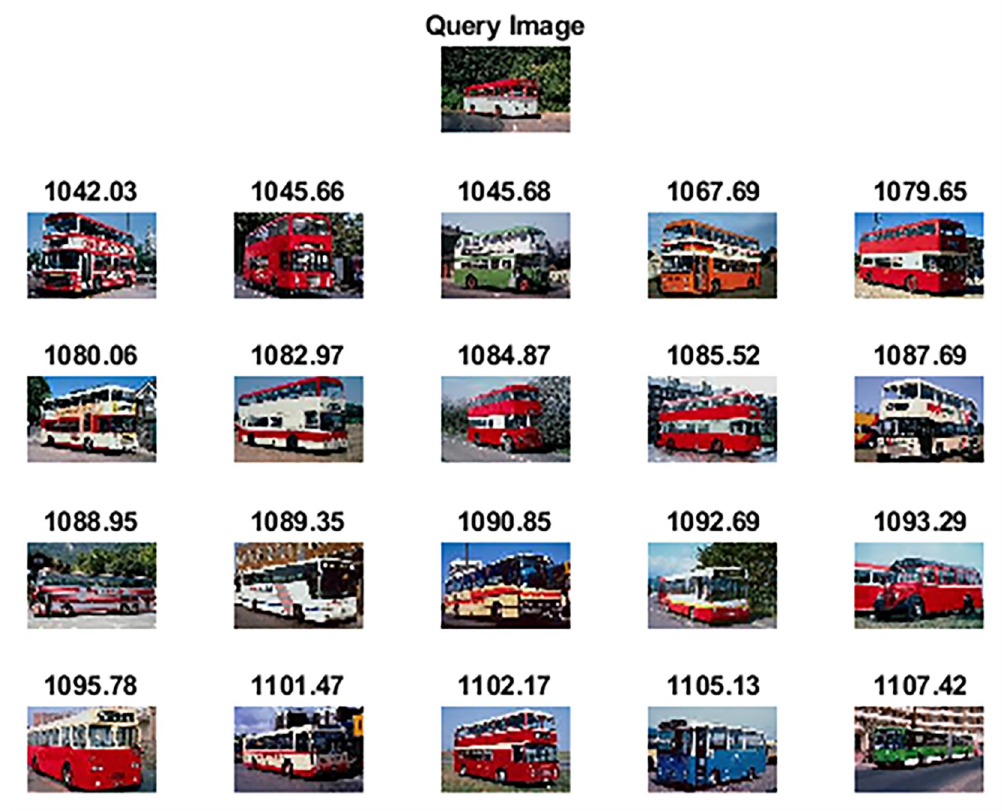
Fig 10. Top-20 retrieved images against query image (class: Bus) (reprinted from [3] under a CC BY license, with permission from J. Z. WANG, original copyright [2003]).